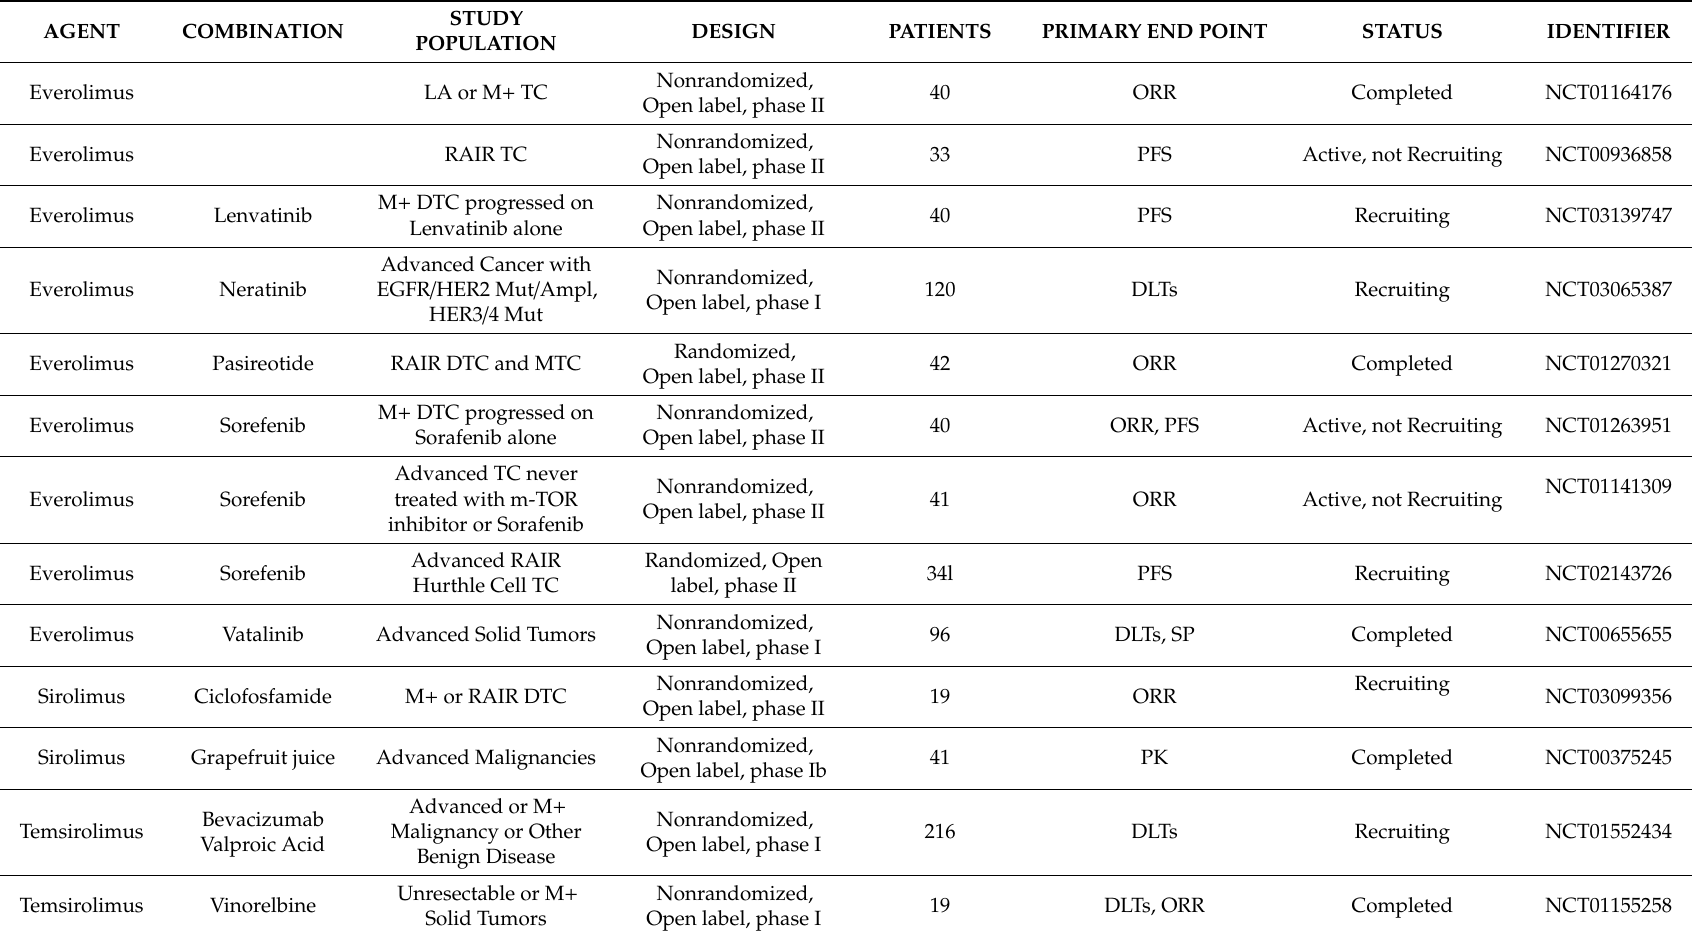
Table 3. Clinical trials with mTOR